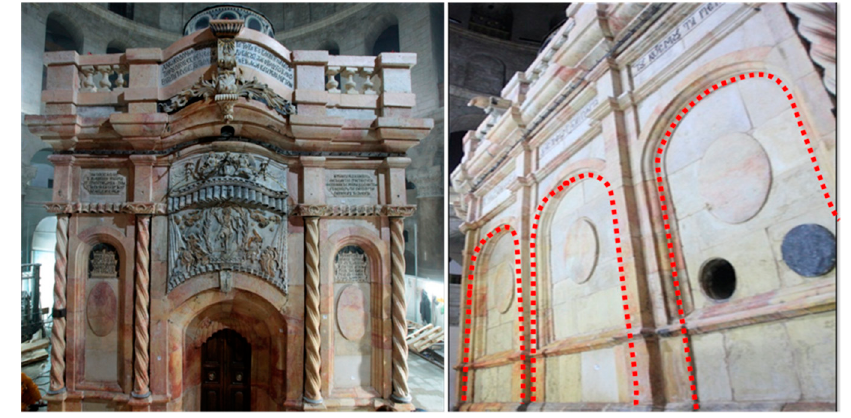
Figure 35. East façade (entrance) of the Holy Aedicule ( left ); façade areas where the stones were removed and then reassembled ( right ).